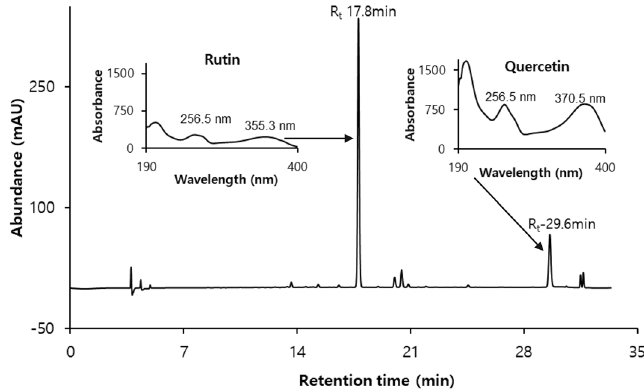
Fig. 4 HPLC chromatogram and the UV spectra of Flos Sophorae extracted by water at 90 ◦